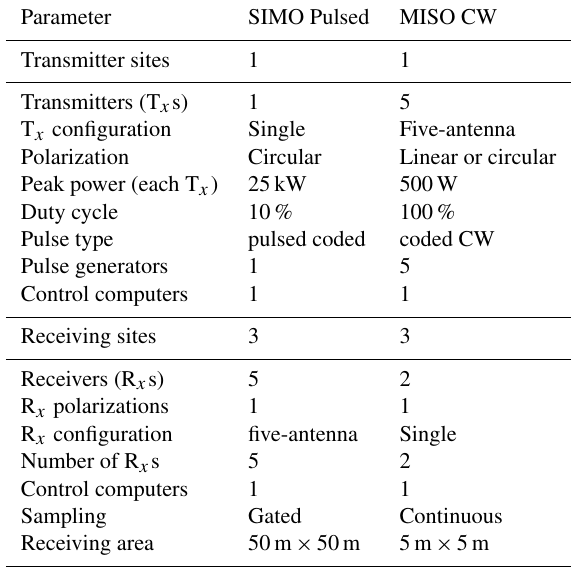
Table 3. Comparisons between a SIMO and a MISO multi-static